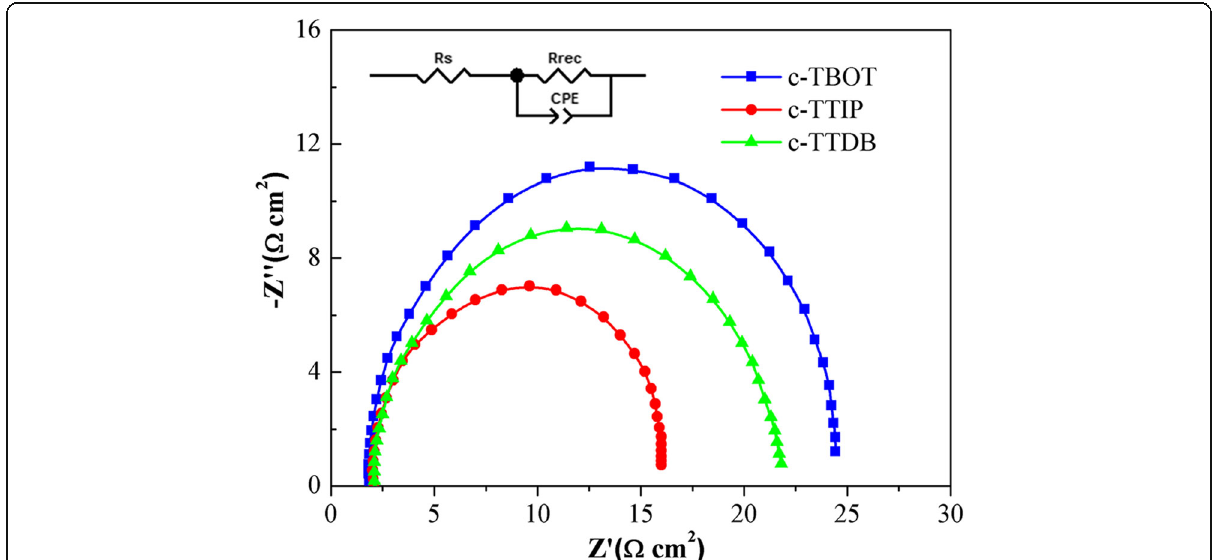
Fig. 8 Nyquist plots of the solar cells based on different compact layers at 0.8 V under AM 1.5G. The inset is the equivalent circuit applied to fit the Nyquist